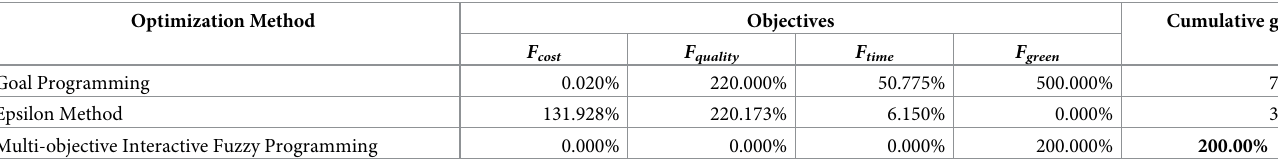
Table 22. Percentage gap in objectives for different optimization